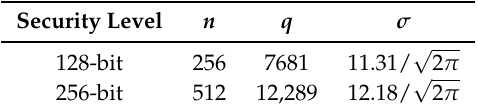
Table 2. Experiment parameters for Ring-LWE implementations.